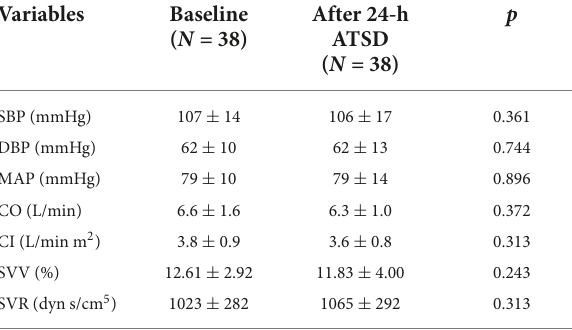
TABLE 3 Mean ± standard deviation of hemodynamic measurements in the supine position before and after 24-h acute total sleep deprivation (ATSD) for healthy